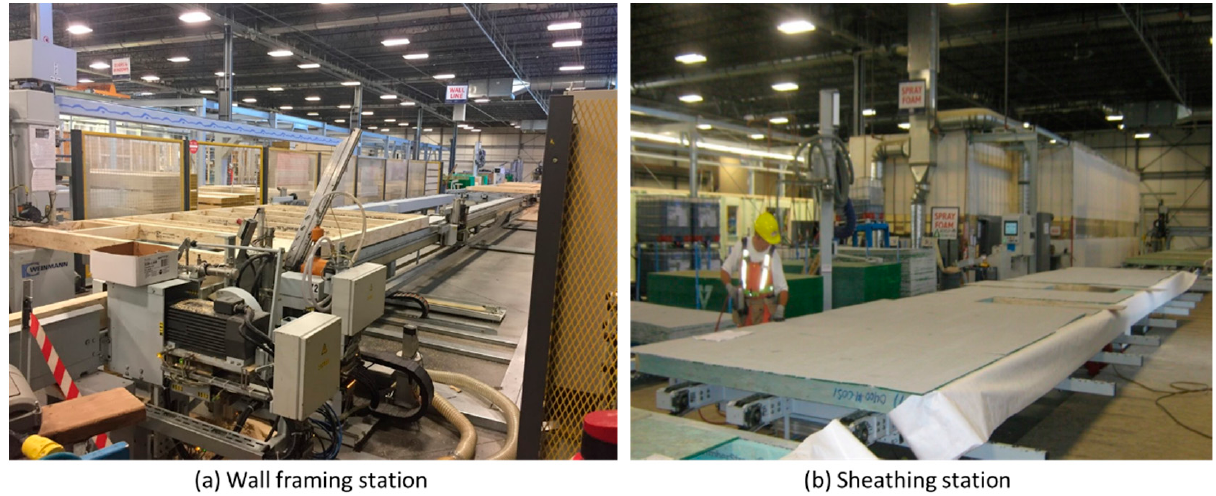
Figure 1. ( a ) Framing, ( b ) sheathing stations of wall production line (courtesy of ACQBUILT, Inc., Edmonton, AB, Canada ) [2].